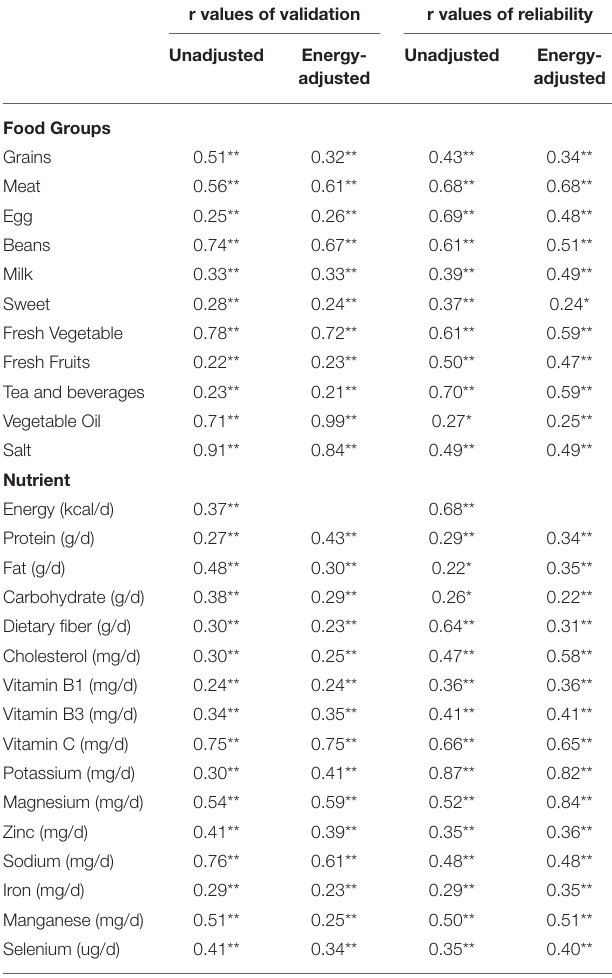
TABLE 1 | The correlation coefficients of validation and reliability analysis. r values of validation r values of reliability